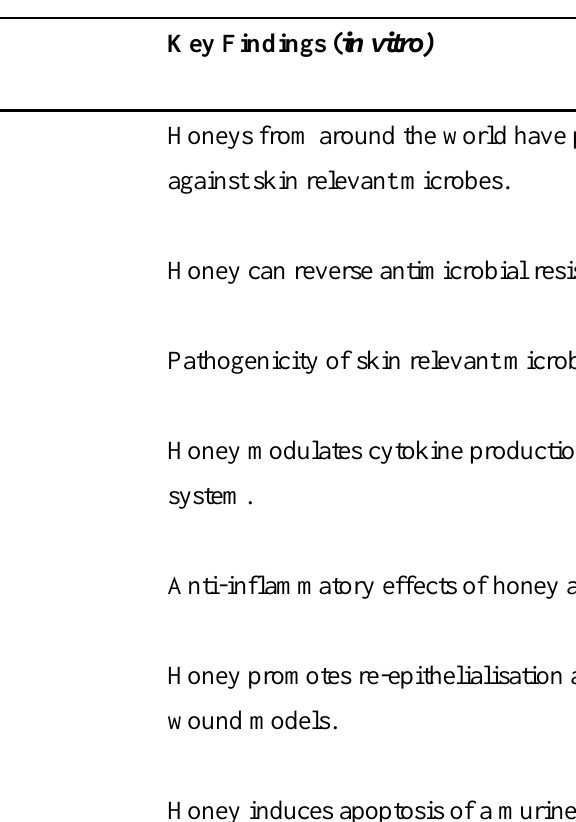
Table 1: Honey as a therapeutic agent for skin disorders; Summary of the key in vitro